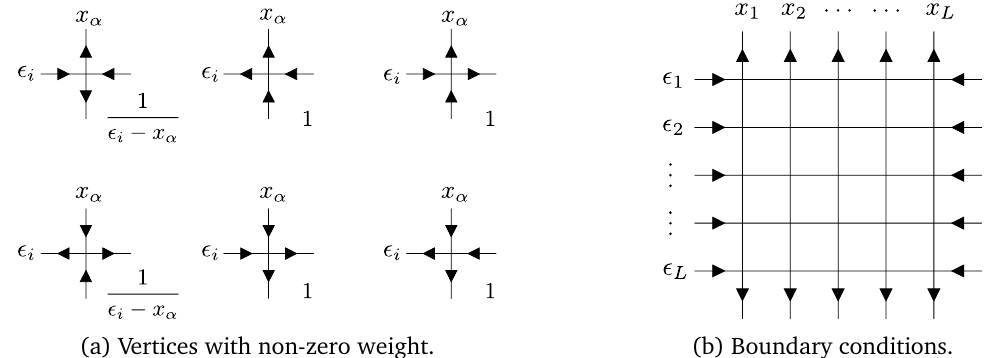
Figure 2: Graphical representation of the DWPF associated with the Bethe states. The partition function sums over all configurations of vertices in the bulk consistent with the boundary conditions, with the total weight of each configuration given by the product of the weights of the vertices. The weights in the first column follow from 〈↑| S + ( x α ) |↓〉